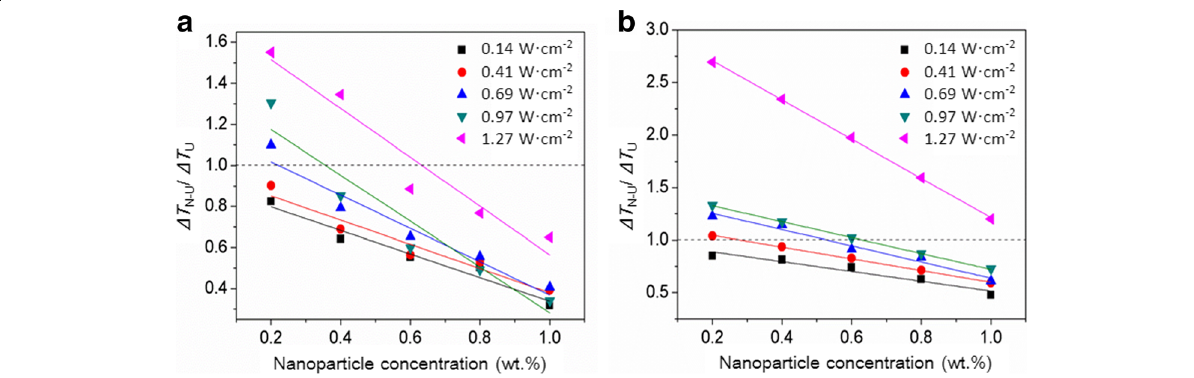
Fig. 5 Comparison of the supercooling degrees of water controlled by ultrasound and nanoparticles mutually and separately [ a Al 2 O 3 nanoparticles, b SiO 2 nanoparticles]. Δ T N-U / Δ T U represents the ratio of supercooling degree required for the water solidification with nanoparticles and ultrasound to that with ultrasound